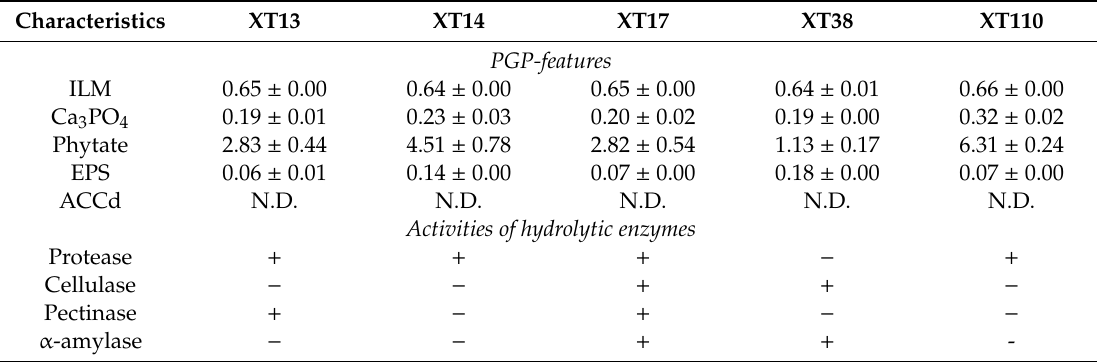
Table 3. Plant growth-promoting (PGP) characteristics of the Bacillus spp. strains assessed. Characteristics XT13 XT14 XT17 XT38 XT110 PGP-features ILM 0.65 ± 0.00